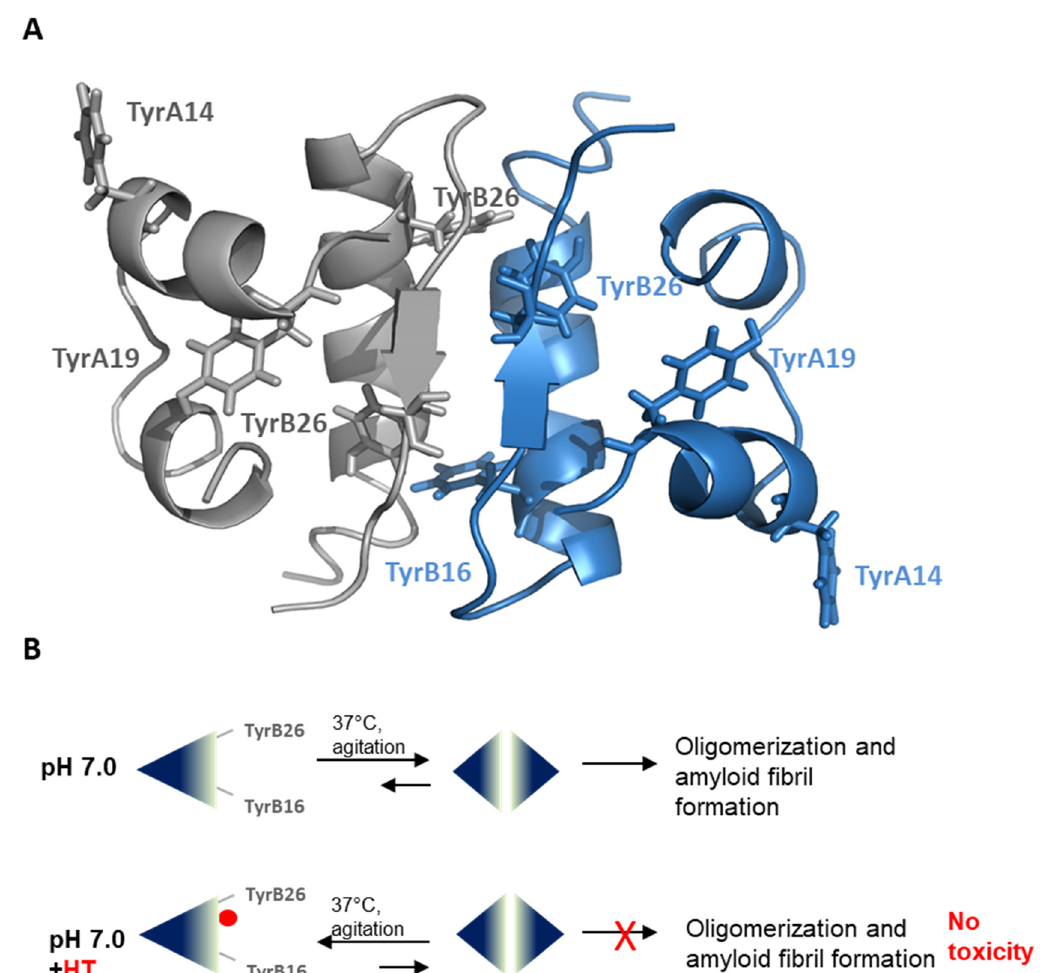
Figure 8. Working hypothesis for HT inhibition in insulin amyloid formation. ( A ) Structural representation of human insulin in its dimeric form (PDB code 3AIY). The two monomers are represented in gray and light blue and tyrosine residues are represented in the tridimensional structure for each monomer. ( B ) Schematic representation of the effect of HT on insulin amyloid formation.